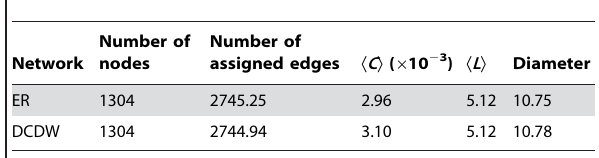
Table 2. Properties of an Erdo¨s-Re´nyi (ER) Random Graph and the Corresponding DCDW Model a